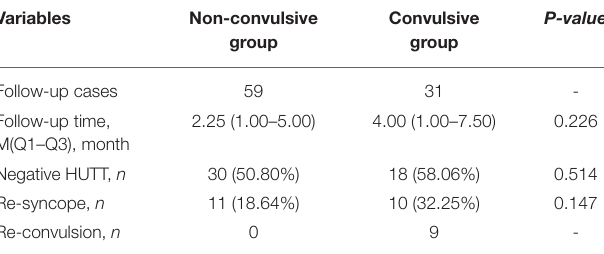
Frontiers in Cardiovascular Medicine |